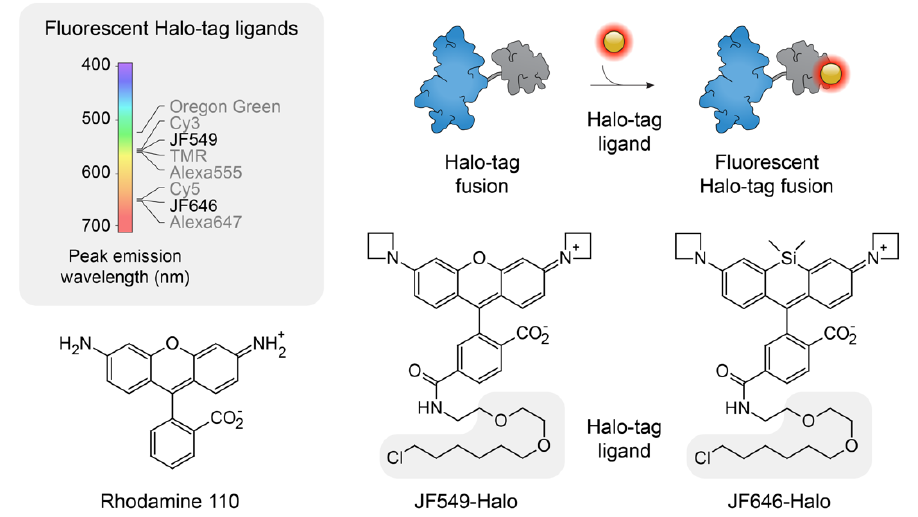
Figure 7. Fluorescent ligands for direct visualization of protein dynamics in native chromatin. Improved photostability of rhodamine-based dyes and conjugation with chloroalkane reagents has resulted in bright, photostable, cell-permeable fluorescent dyes compatible with the Halo-tag system.